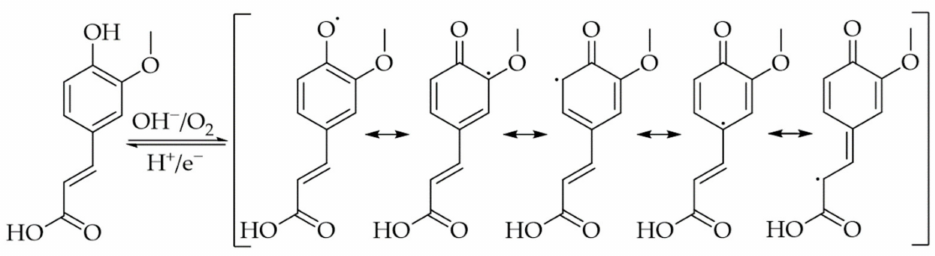
Figure 4. Formation of the o -semiquinone radicals of